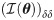
Application to the SLAMseq experiment.A: Diagonal term of the FIM (I(θ))δδ as a function of chase time. Similar to Fig 2, we normalize it as (I(θ))δδδ2, so it corresponds to the lower boundary of the relative variance var(δ^)/δ2⩾1/((I(θ))δδδ2). Using time points with low (I(θ))δδ values results in higher variance of δ^. In this example, as values of μ^1 and μ^2, we use medians of their estimations from the model fitted to the full set of points. B: Relative width of 95% confidence intervals (CI) for the rate estimations δ^. We use the genes with μ^2 located between 40%-60% percentiles (i.e. near the median). Genes, which have ratio close to the optimum t/τ ≈ 2.9 (subfigure (A)), have smaller relative CI for δ^.